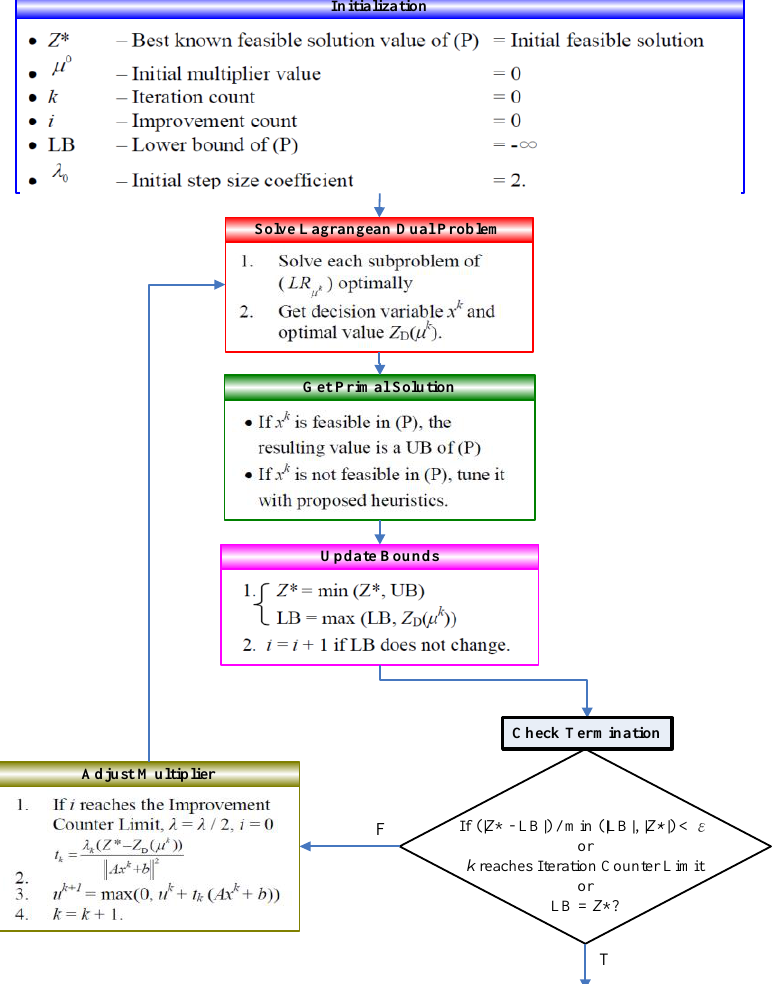
Figure 3. Lagrangian Relaxation